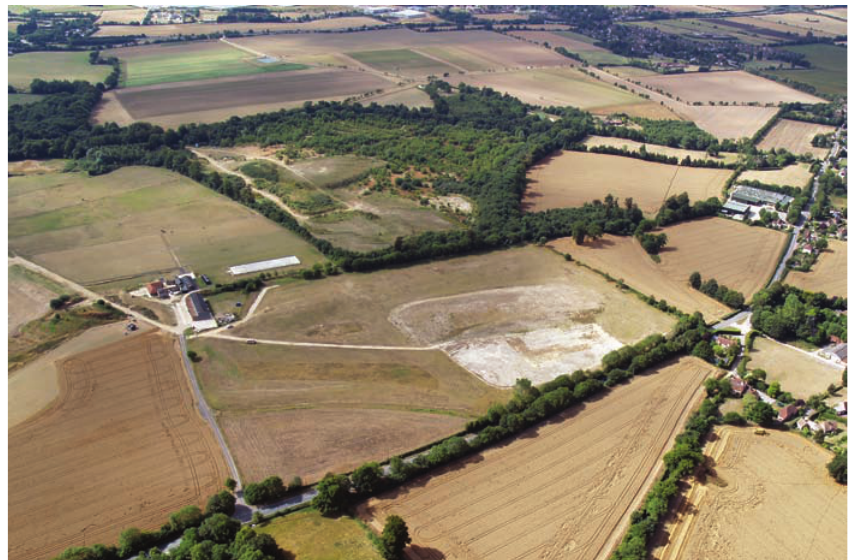
Figure 4 The restored Quarry 1 from the air, looking south. The footprint of the old trench at Q1/B can be seen in the expanded excavation